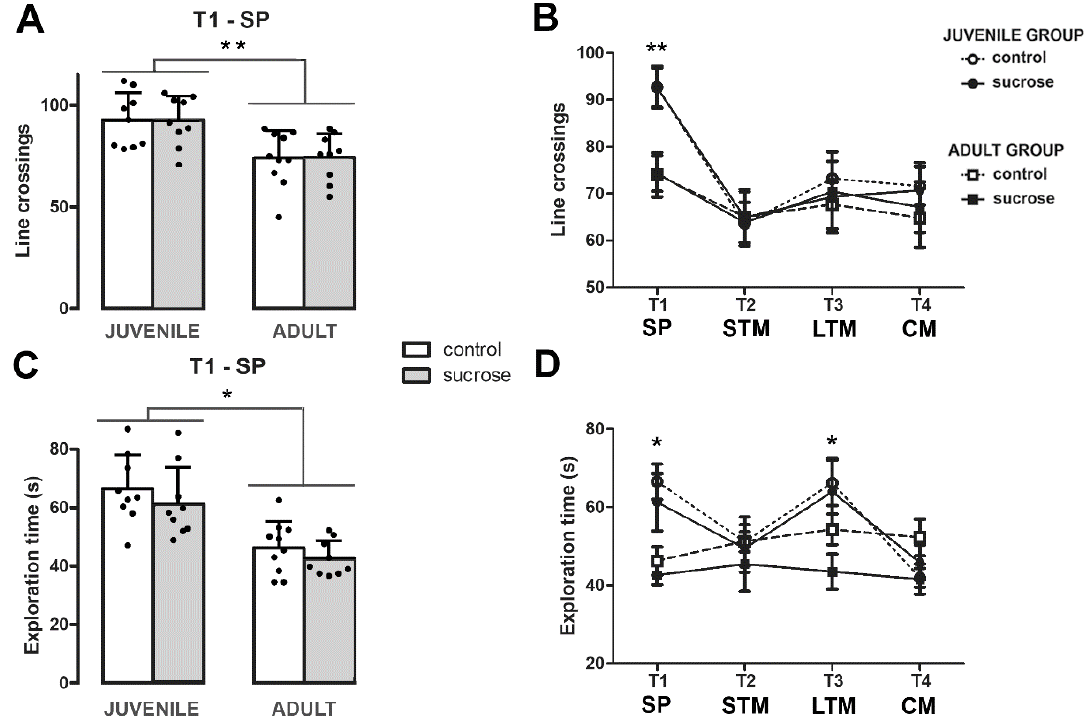
Figure 3. ( A ) Locomotor activity during the familiarization session and ( B ) during T1–T4 NOR trials. ( C ) Total time spent exploring the objects during the familiarization session and ( D ) during the T1– T4 NOR trials. No significant differences in locomotor activity or the total exploration time were found between the control and sucrose groups by two-way ANOVA and two-way RM ANOVA. SP, sample phase (T1); STM, short-term memory (T2); LTM, long-term memory (T3); and CM, con- solidated memory (T4). Data are presented as mean ± SD from two independent experiments, n = 9–10. Tukey’s post hoc test showed only differences by age, ** p < 0.005, and * p < 0.01.